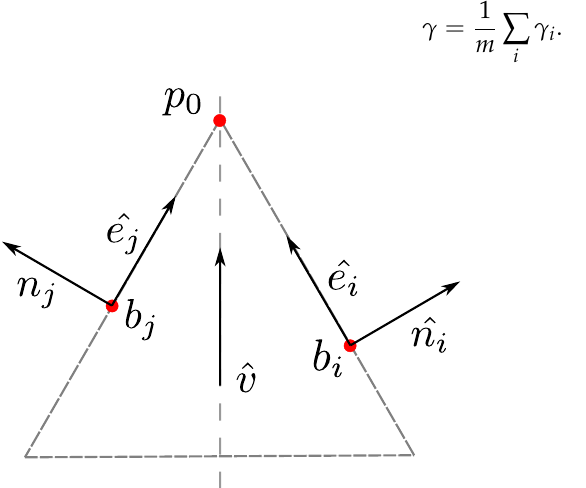
Figure 11. Cone 2D example. Vectors e i point to p v and are perpendicular to n i